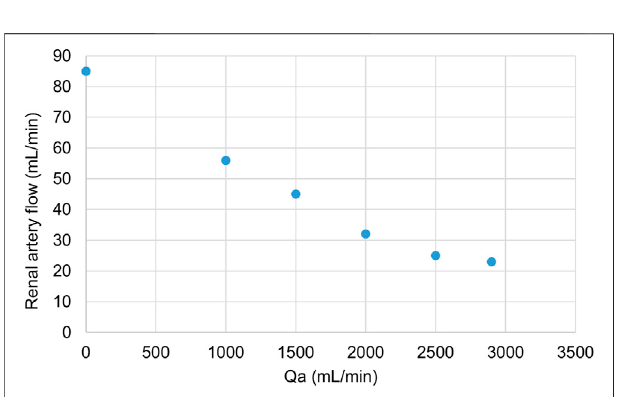
FIGURE 5 | Changes in renal artery fl ow with increasing Qa. Displayed values were obtained from one subject. Qa was regulated by a clamp on the ECMO